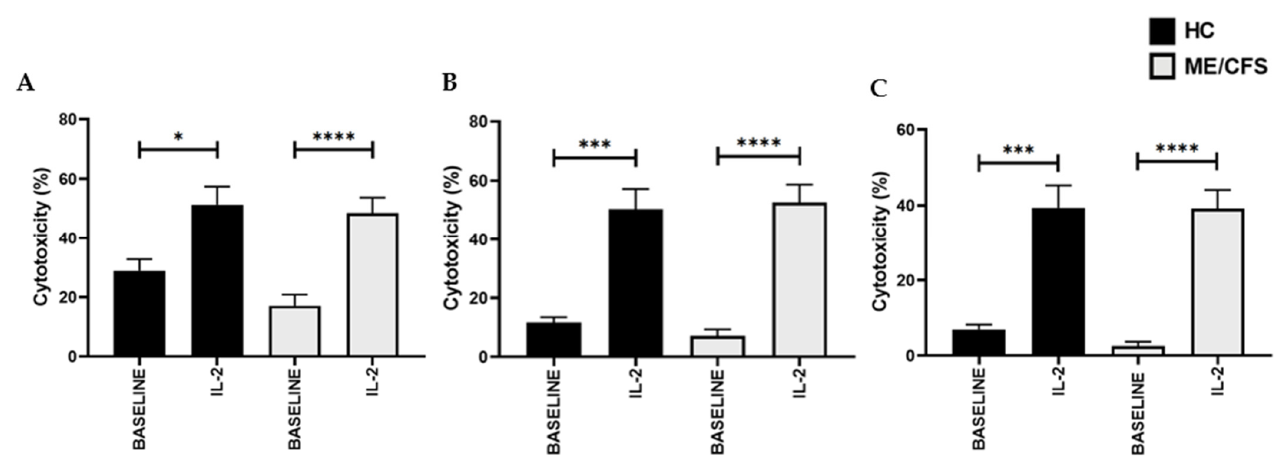
Figure 2. NK cell cytotoxicity at baseline compared with post-IL-2 stimulation; n = 17 for HC and n = 17 for ME/CFS. ( A ) 25:1 ratio ( B ) 12.5:1 ratio ( C ) 12.5:1 ratio. A significantly higher NKCCA was observed in both HCs and ME/CFS patients